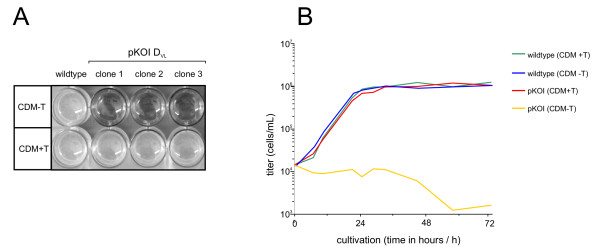
Growth of DHFR-TS deficient T. thermophila compared to wildtype. A: Selection of DHFR-TS knock out cells by growth on thymidine. T. thermophila cells with disrupted DHFR-TS gene (clone 1–3) do not grow without the presence of thymidine (CDM-T), whereas wildtype cells do. Addition of thymidine to the medium (CDM+T) recovers growth. B: Growth kinetics of DHFR-TS knock out cells compared to wildtype cells in media with or without thymidine show, that the knock out strain (pKOI) is growing as fast as wildtype cells on thymidine supplemented media (CDM+T). Knock out cells die without thymidine present (CDM-T). The curves are calculated by mean values of at least three independent experiments.